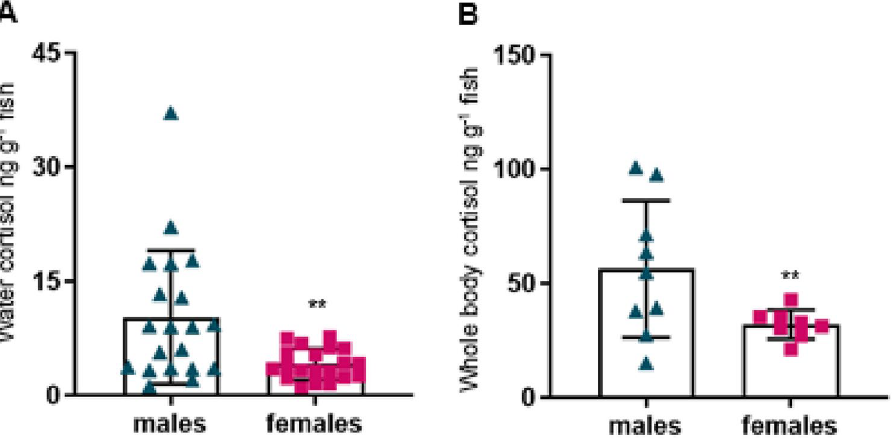
Figure 3. Cortisol levels is higher in males compared to female zebrafish. The magnitude in post-stress cortisol levels measured in ( A ) holding-water and ( B ) whole-body were lower for females compared to males. Statistical differences were tested by two-tailed un-paired t-tests. ** p < 0.01 males versus